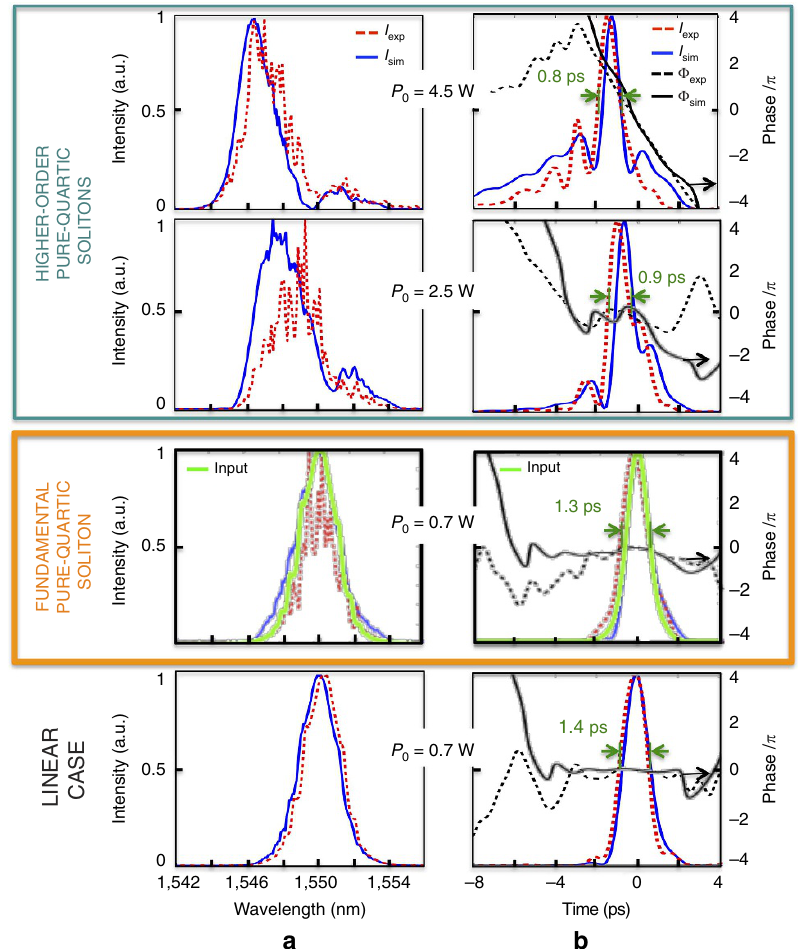
Figure 2 | Experimental and modelling results. ( a ) Frequency and ( b ) time domain results for different input powers. The dashed red lines represent the intensity measurements, the blue solid lines represent the intensity simulations, the black dashed line represents the measured phase, and the solid black line represents the simulated phase. The green solid line at 0.7W represents the normalized input intensity. The yellow box encompasses the fundamental pure-quartic soliton, showing nearly unperturbed propagation and flat temporal phase. The turquoise box includes two cases of higher-order pure-quartic solitons, showing temporal compression and nonlinear spectral broadening. The higher-order pure-quartic solitons observed here are greatly perturbed by the presence of free